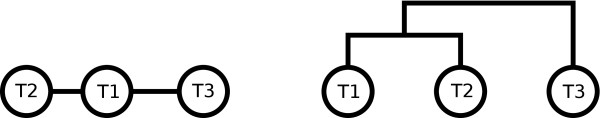
MSTs and time-series data. An example with a time-series data set of three samples (T1, T2, and T3) where the dissimilarity between T1 and T2 is the smallest, but between T2 and T3 is the largest. This phenomenon is depicted well by the MST (left), but not by the dendrogram (right) since T1 and T2 are part of the same sub-tree and could be re-ordered depending on the hierarchical clustering implementation.